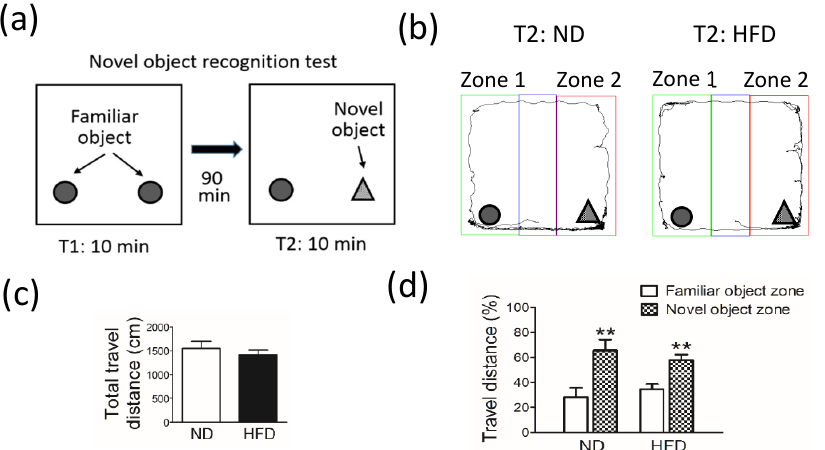
Figure 3. Cognitive function of middle-aged rats evaluated by using the novel object recognition test after rats were fed a normal diet (ND, control, n=8) or 45% high-fat diet (HFD, n = 8) for 30 weeks. ( a ) A schematic of the novel object recognition test is shown. Data in ( b – d ) show the ( b ) travel tracks, ( c ) total travel distance (cm), and ( d ) percentage (%) of travel distance in a familiar (zone 1) and novel object (zone 2) zone after 30 weeks. Behavior was analyzed by using a camera and an authorized image-tracking software (Panlab Smart video-tracking software). Data in ( c , d ) are expressed as the mean ± SEM. ** p < 0.01 between familiar and novel object zones within the same group ( t -test).